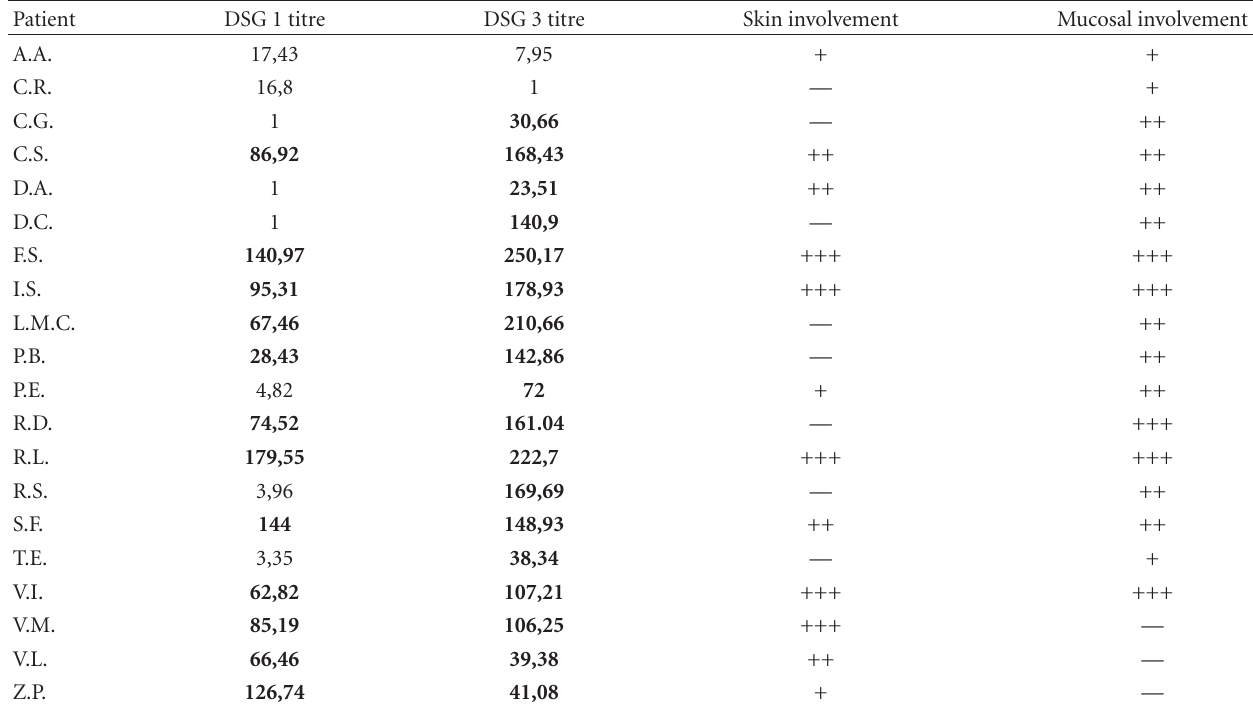
Table 2: Autoantibodies titres at the time of diagnosis